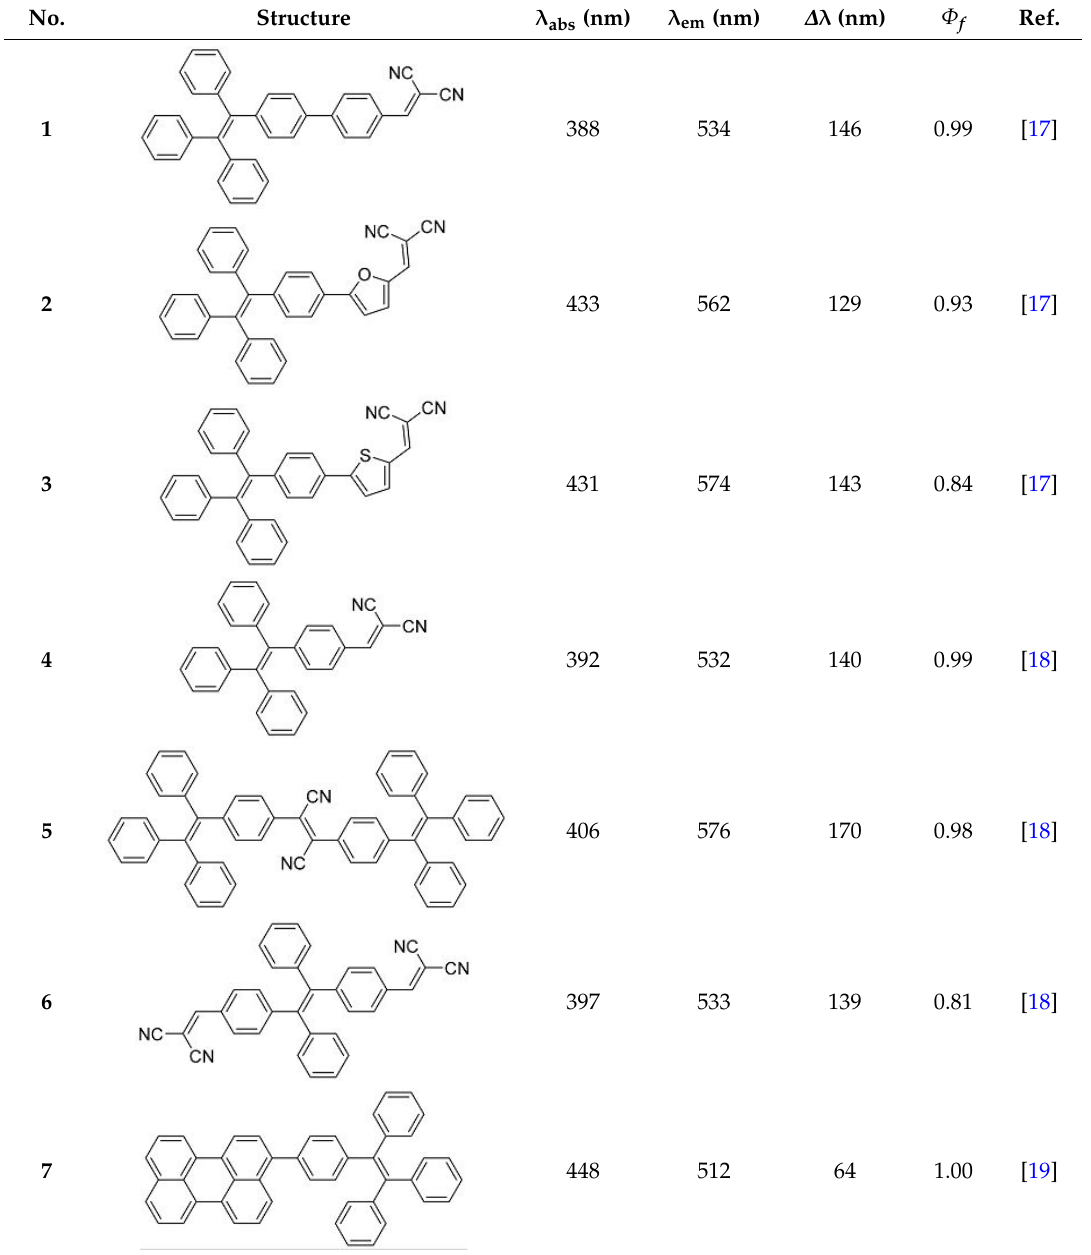
Table 1. Structures and optical properties of fluorophores with Aggregation-Induced Emission properties (AIEgens) used in Luminescent Down-Shifting (LDS)